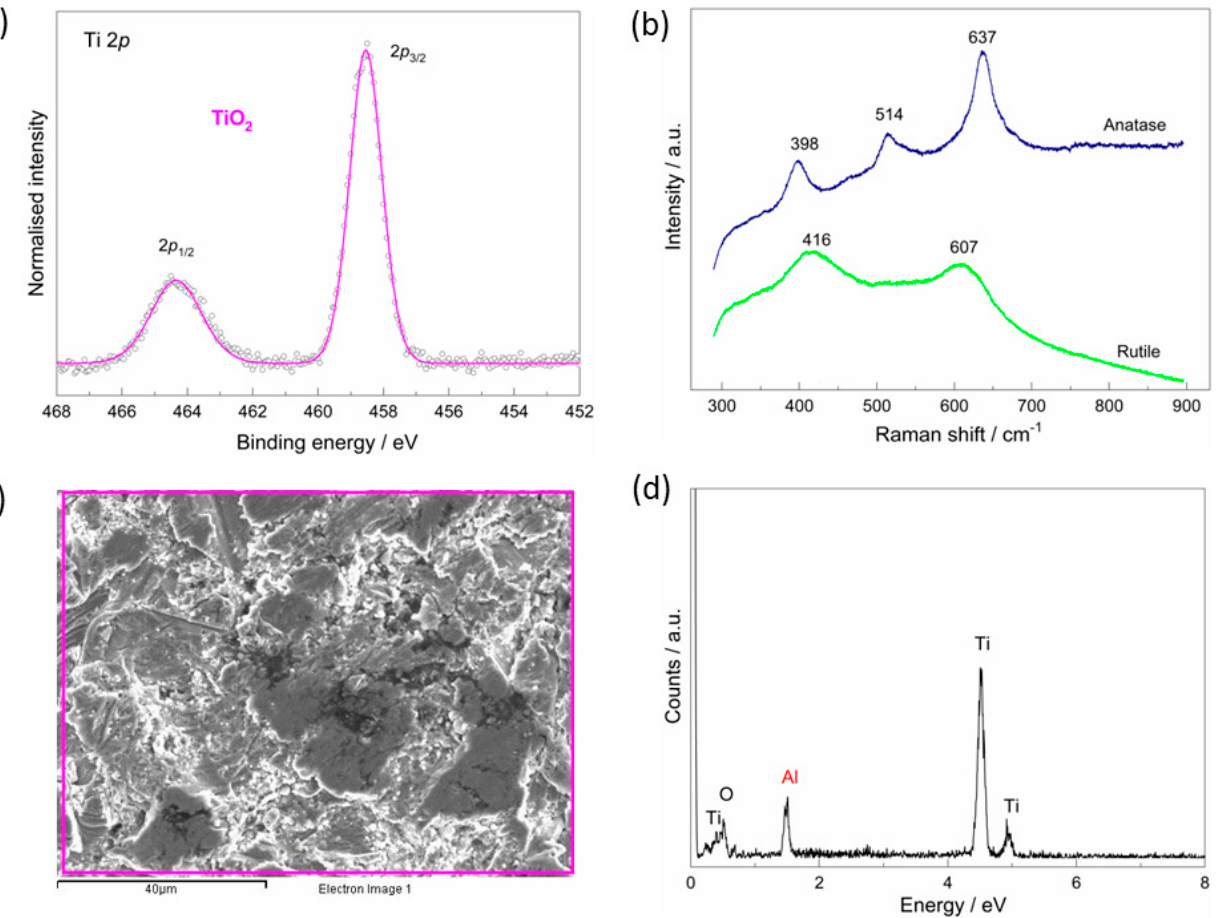
Figure 1. The characterisation of the as-received implant surface: ( a ) high-resolution XPS spectrum around the Ti 2 p core level [13]; ( b ) Raman spectra of the crystalline forms of TiO 2 : rutile (green) and anatase (blue); ( c ) SEM image of the implant surface; ( d ) corresponding EDS spectrum obtained on the surface area shown in ( c ).